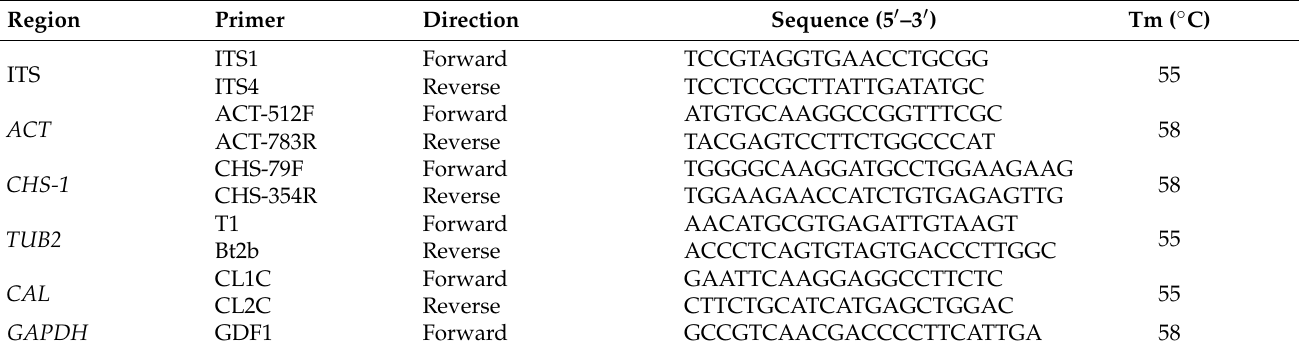
Table 3. PCR primers used for molecular characterization of Colletotrichum